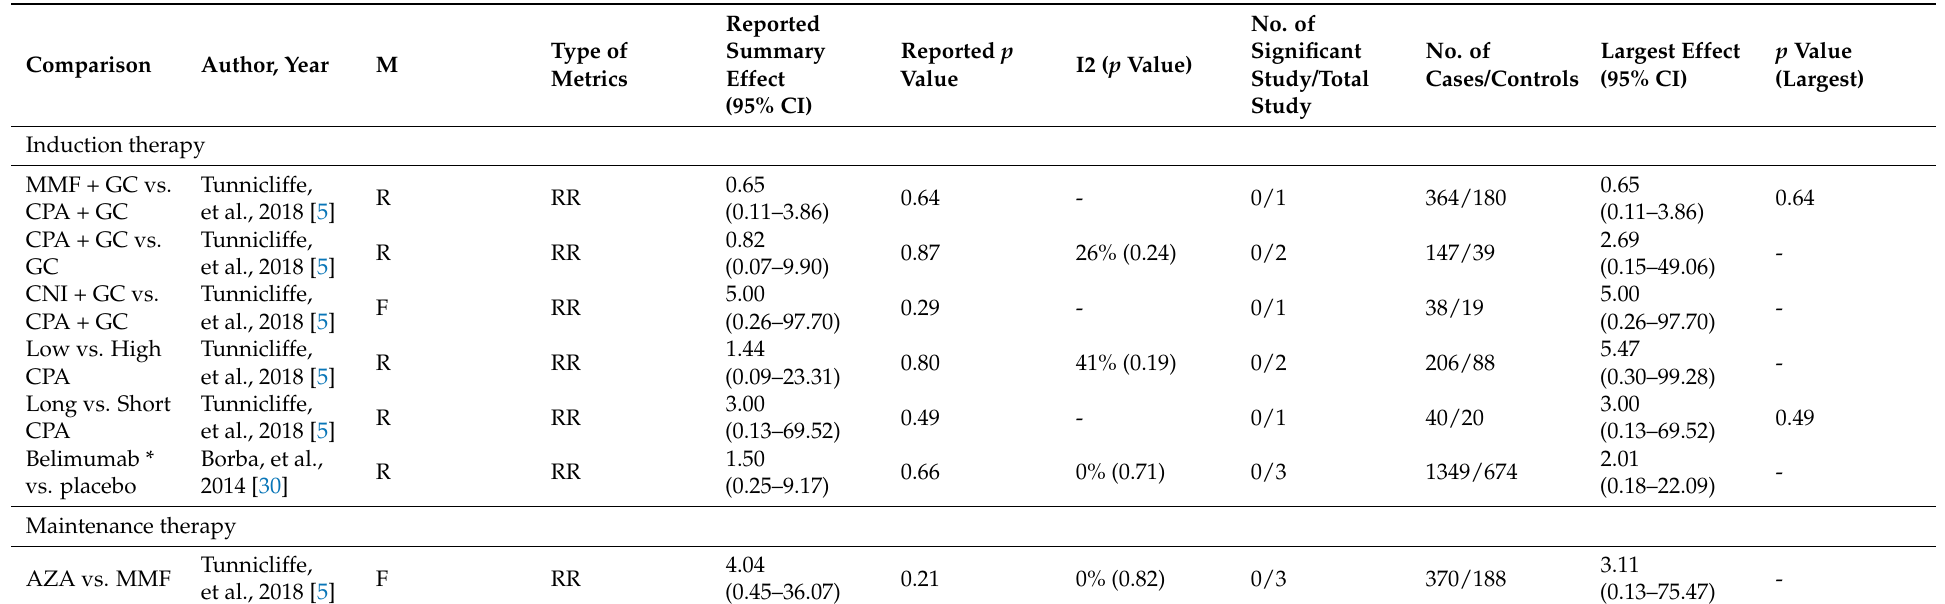
Table 16. Malignancy during induction and maintenance therapy of lupus nephritis.